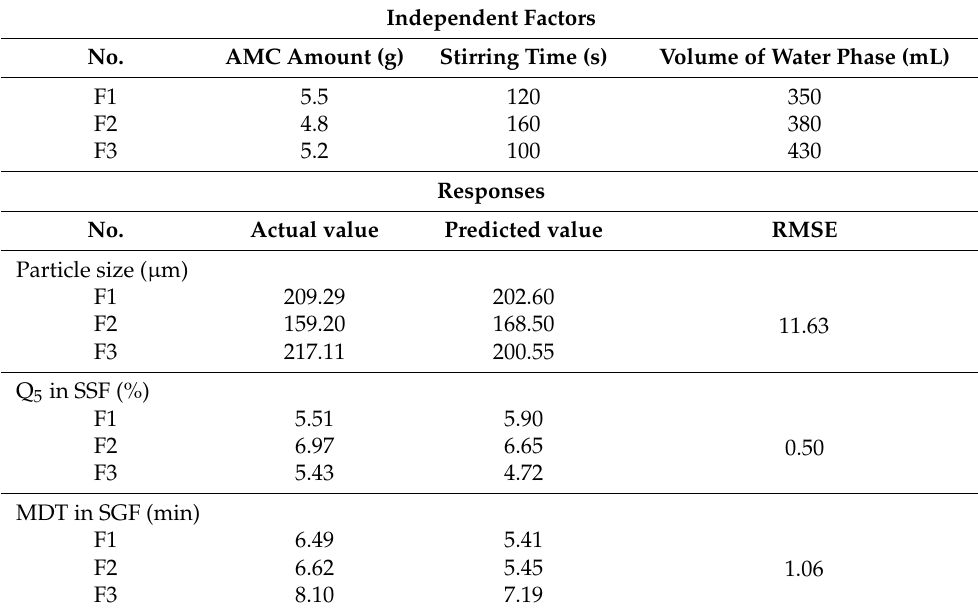
Table 7. Comparison of the difference between actual and predicted value of responses for model